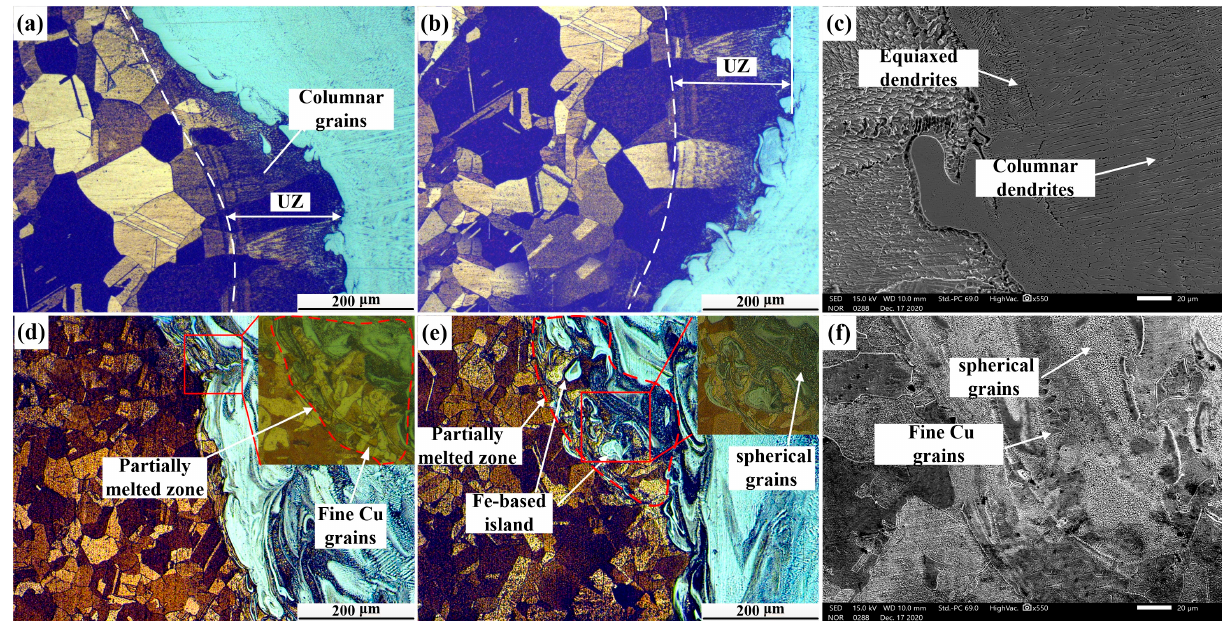
Figure 5. Optical micrographs of the Cu/weld interface in joints: ( a ) optical image of C1 in joint 1; ( b ) optical image of C2 in joint 1; ( c ) SEM image of joint 1; ( d ) optical image of C1 in joint 2; ( e ) optical image of C2 in joint 2; ( f ) SEM image of joint 2.